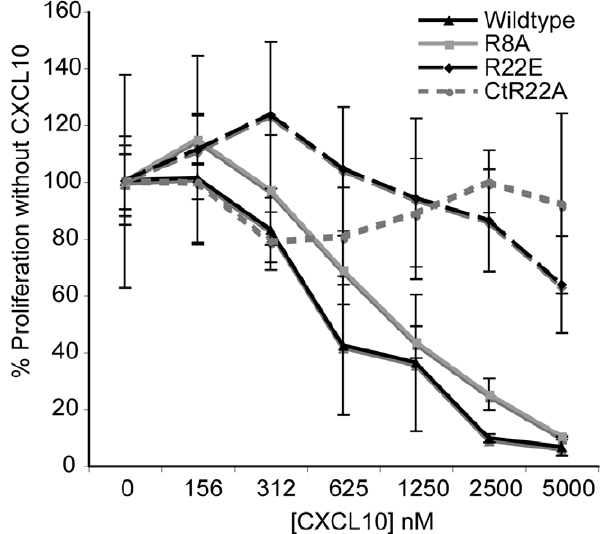
Figure 8. CXCL10’s anti-proliferative effect correlates with GAG binding, but not CXCR3 binding. HUVEC were plated in 96-well plates with bFGF. 24 hr after seeding, new media with CXCL10 (wt or mutants) was added and replaced every 48 hr for a total of 3–4 days. Mutant R8A is devoid of CXCR3 signaling, but has normal heparin binding affinity. Mutant R22E has low heparin binding affinity and low CXCR3 signaling, and mutant CtR22A has minimal CXCR3 signaling and very low heparin binding affinity. 3 H-thymidine incorporation was assessed for the final 18 hr of incubation. Representative data of at least three experiments are shown, each performed in triplicate, data are mean 6 SD.